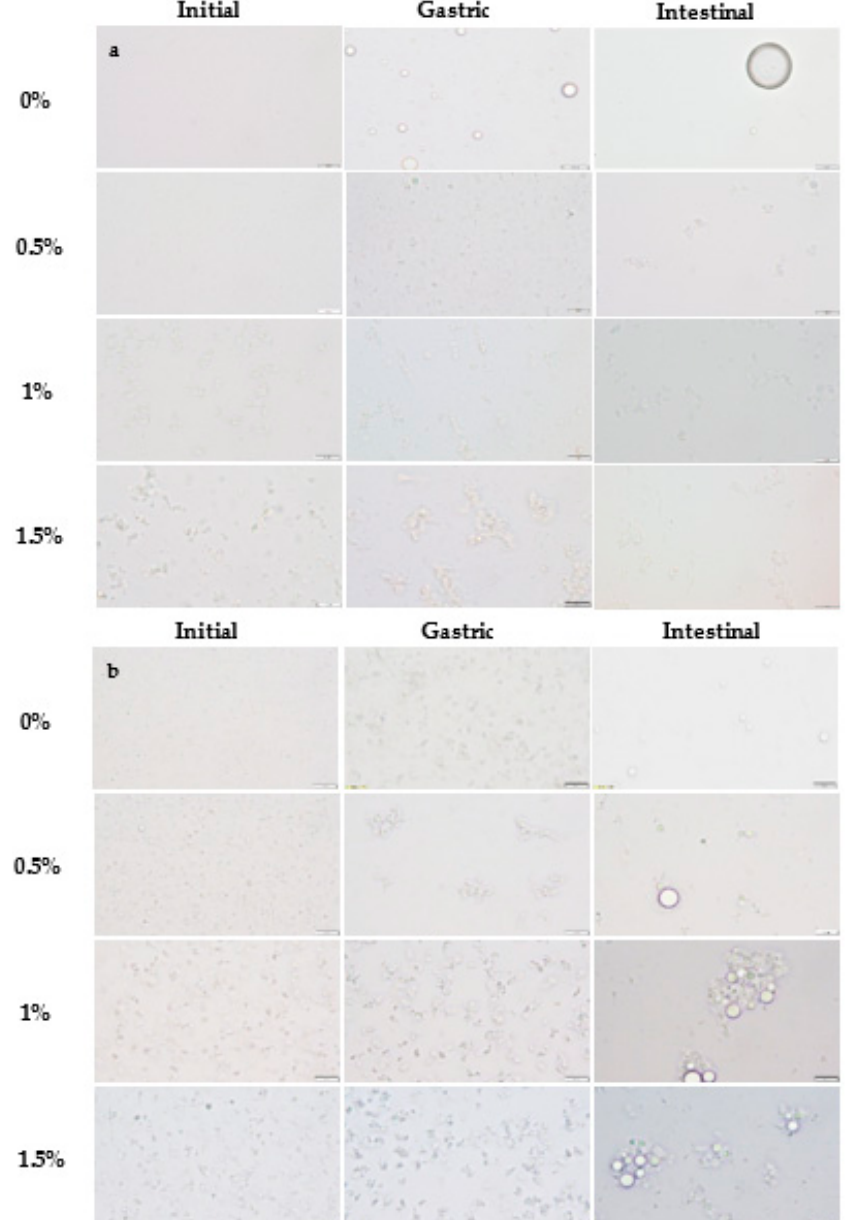
Figure 2. Microscope images of curcumin-loaded nanoemulsions stabilized with ( a ) soybean lecithin (SBL) or ( b ) whey protein isolate (WPI) and different sodium alginate concentrations (0, 0.5, 1 and 1.5%) at different phases of in vitro digestion. Scale bars were 10 µm long.